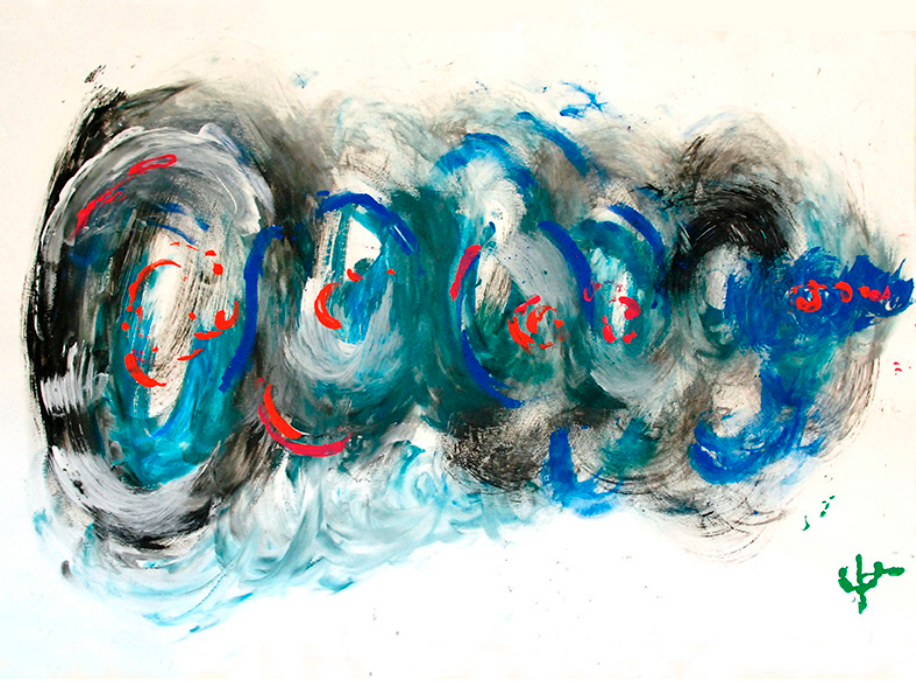
Figure 5. Kevin (aged 23, multi-substance abuse), Vortices, Vortices that Pull You